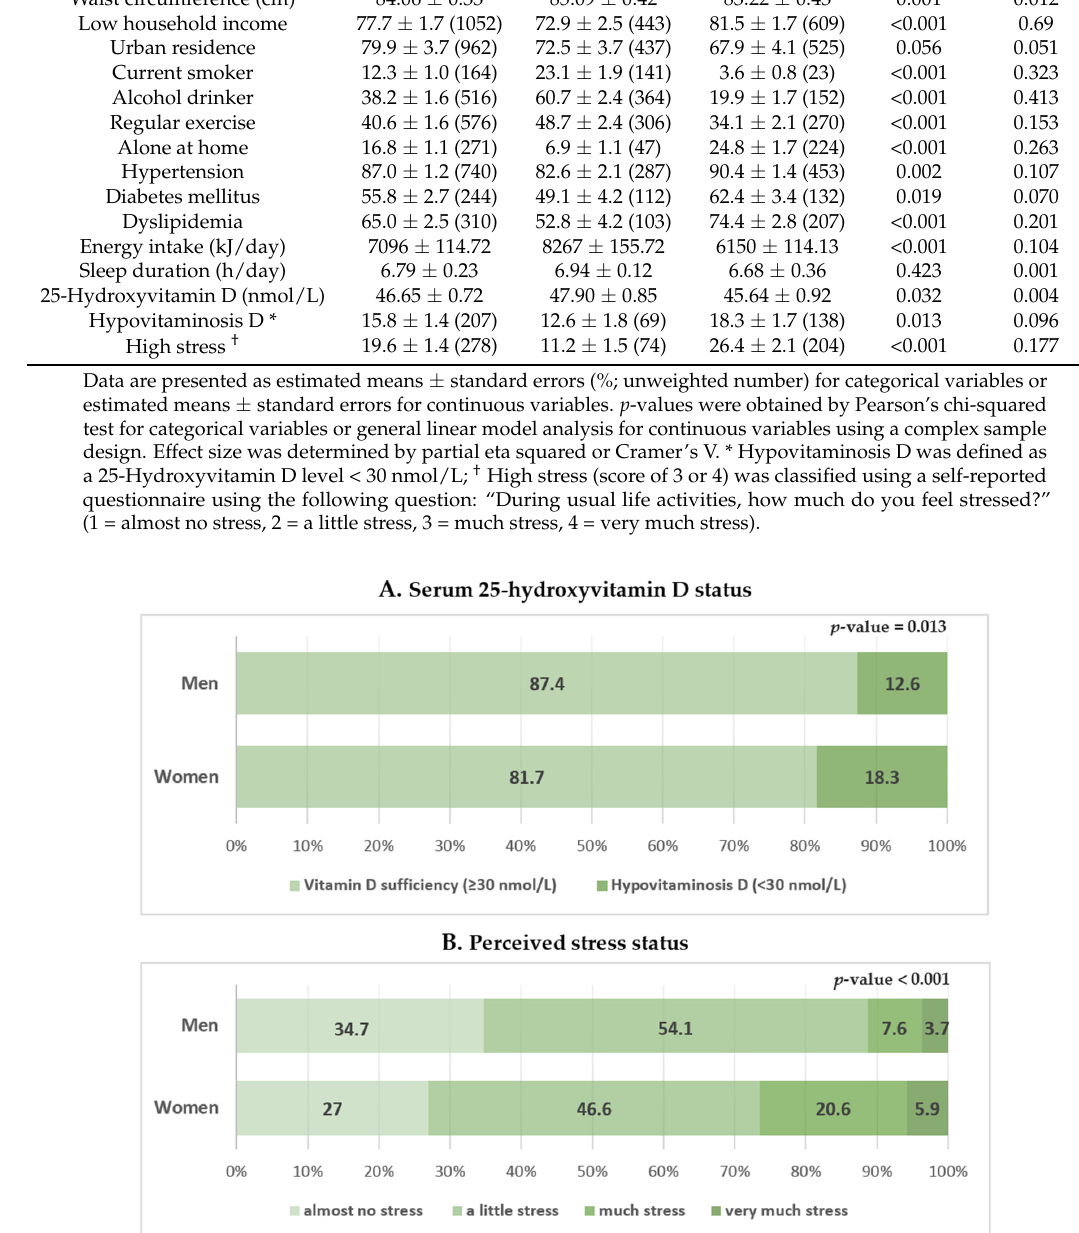
Table 1. General characteristics of study participants by sex.